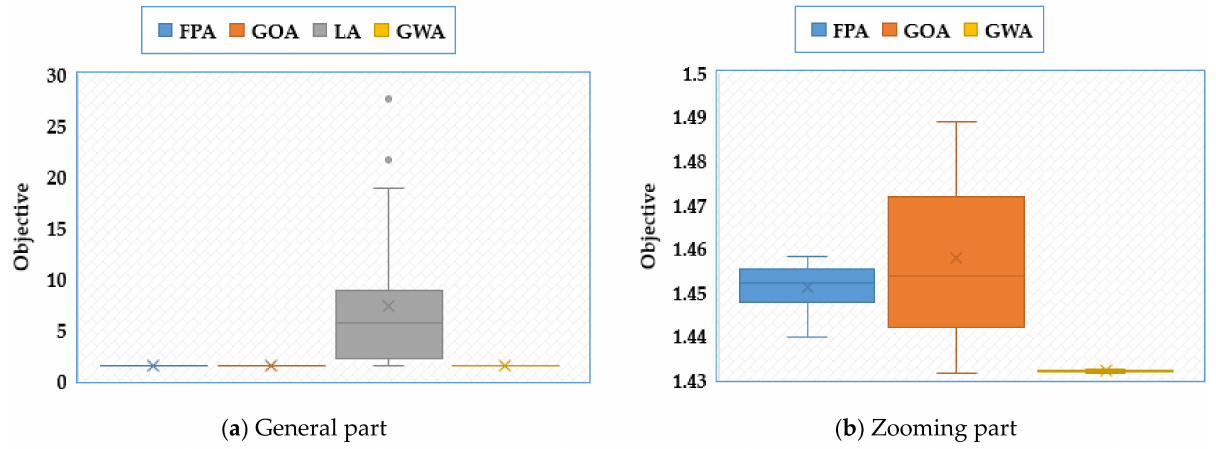
Figure 7. Box and Whiskers plot of GWA, FPA, LA, and GOA for TLSM design under first case. Table 2. Robustness indices of GWA, FPA, LA, and GOA for TLSM design under first case. Robustness Indices